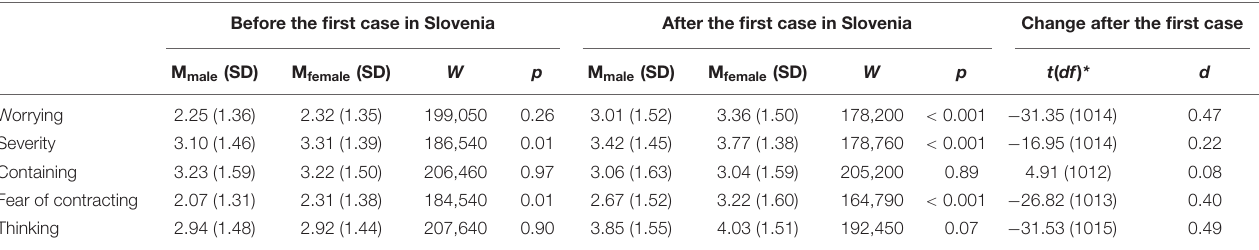
TABLE 1 | Mean scores and gender differences for perceptions of different aspects of COVID-19 before and after the first confirmed case with changes in perceptions after the first confirmed case in Slovenia. Before the first case in Slovenia After the first case in Slovenia